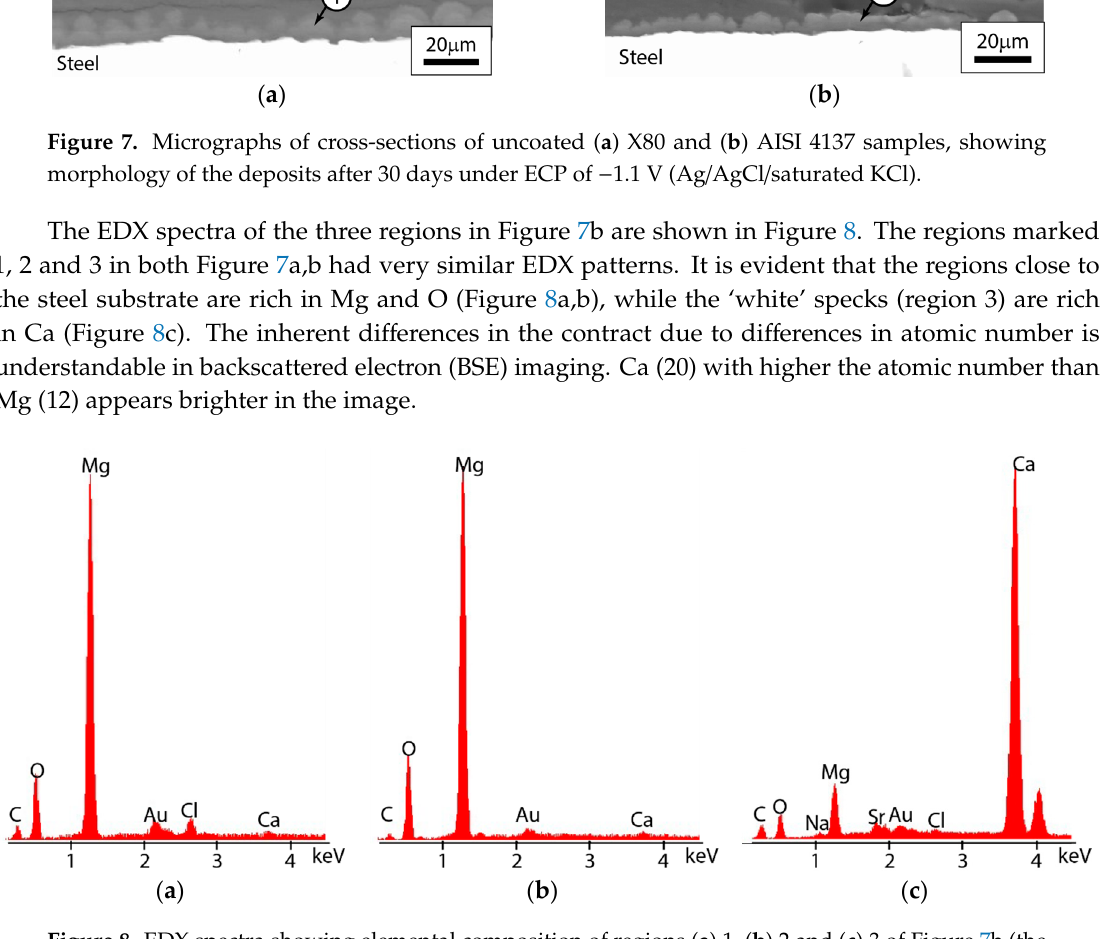
Figure 8. EDX spectra showing elemental composition of regions ( a ) 1, ( b ) 2 and ( c ) 3 of Figure 7b (the deposit formed on uncoated AISI 4137).